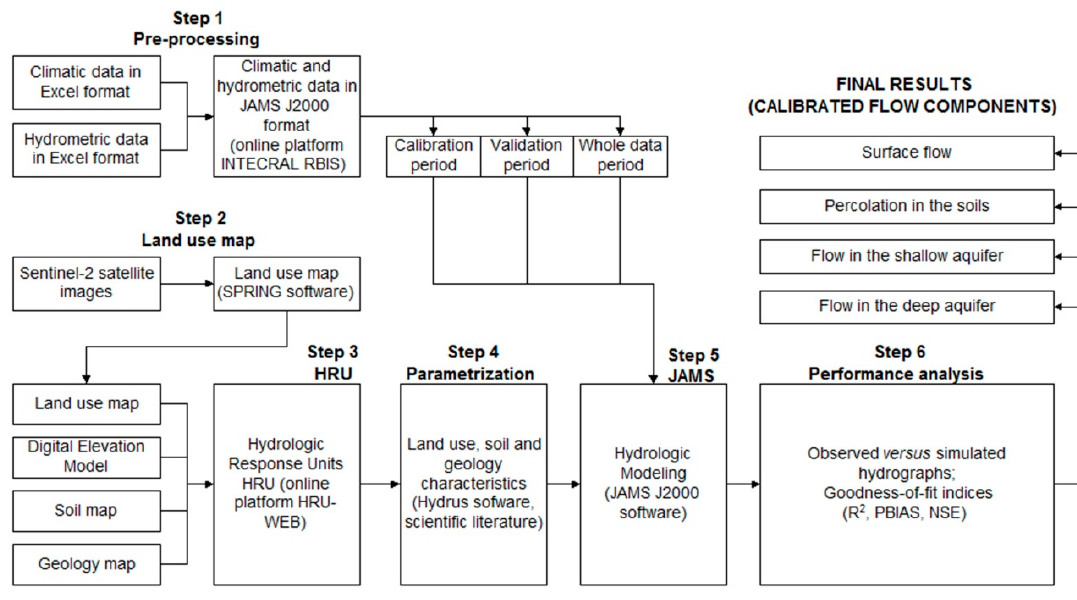
Figure 2. Workflow used to perform the hydrologic modeling.